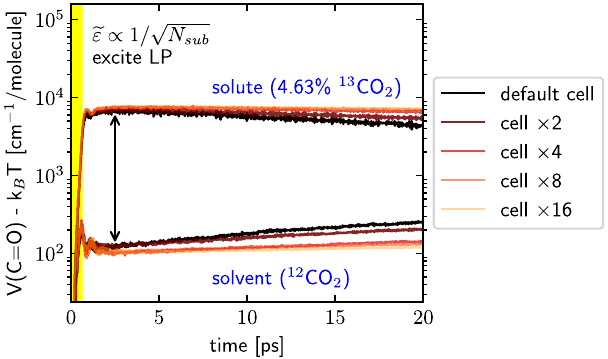
Fig. 4 Effects of the molecular system size on the dynamics of the C = O bond potential energy at constant solute concentration. The Rabi splitting and molecular number density have been fi xed. Black lines correspond to the data in Fig. 3b ( N sub = 216), and the lines from dark red to orange represent increasing molecular systems where N sub is increased by a factor of N ( N = 2, 4, 8, 16). In all cases, we excite the LP and measure the amount of potential energy in the C = O bonds. Note that the selective polaritonic energy transfer to the 13 CO 2 solute molecules is fairly robust against molecular system size, indicating that the current fi nding may hold for collective VSC with large cavity volumes but under the same Rabi splitting, i.e., smaller e ε ; see text below and also Supplementary Fig. 1 for an explanation of the system size